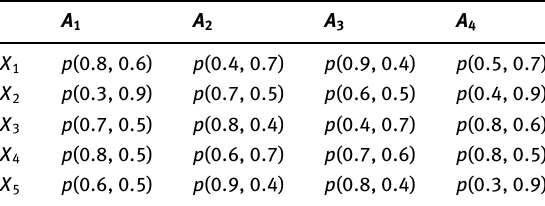
Table 3: Pythagorean Fuzzy Decision Matrix R (3)